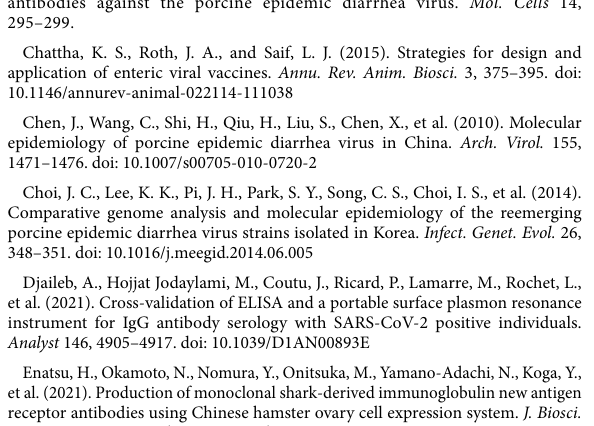
SUPPLEMENTARY FIGURE 1 Identification of CHO-expressed chimeric IgG/IgA by SDS-PAGE. SDS-PAGE analysis of CHO-expressed chimeric IgG/IgA under reducing conditions (A) and non-reducing conditions (B) in the 5, 6 and 7 day-post-transfection (dpt). Black arrows indicated the heavy and light chains. SUPPLEMENTARY FIGURE 2 Identification of the PEDV chimeric IgG/IgA expression level in CHO clones. Red circles indicate 12 CHO clones selected for IgG/ IgA expression quantification. The positive and negative control dots in the WB assay are located at the bottom right of the